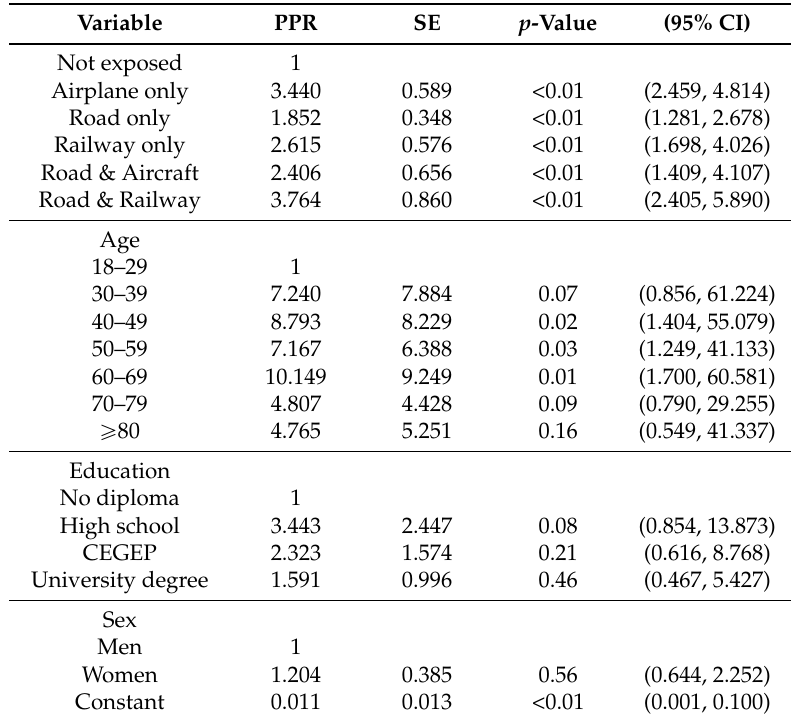
Table A16. Log-binomial regression models for sleep disturbance by transportation noise according to proximity to single and combined sources of transportation noise